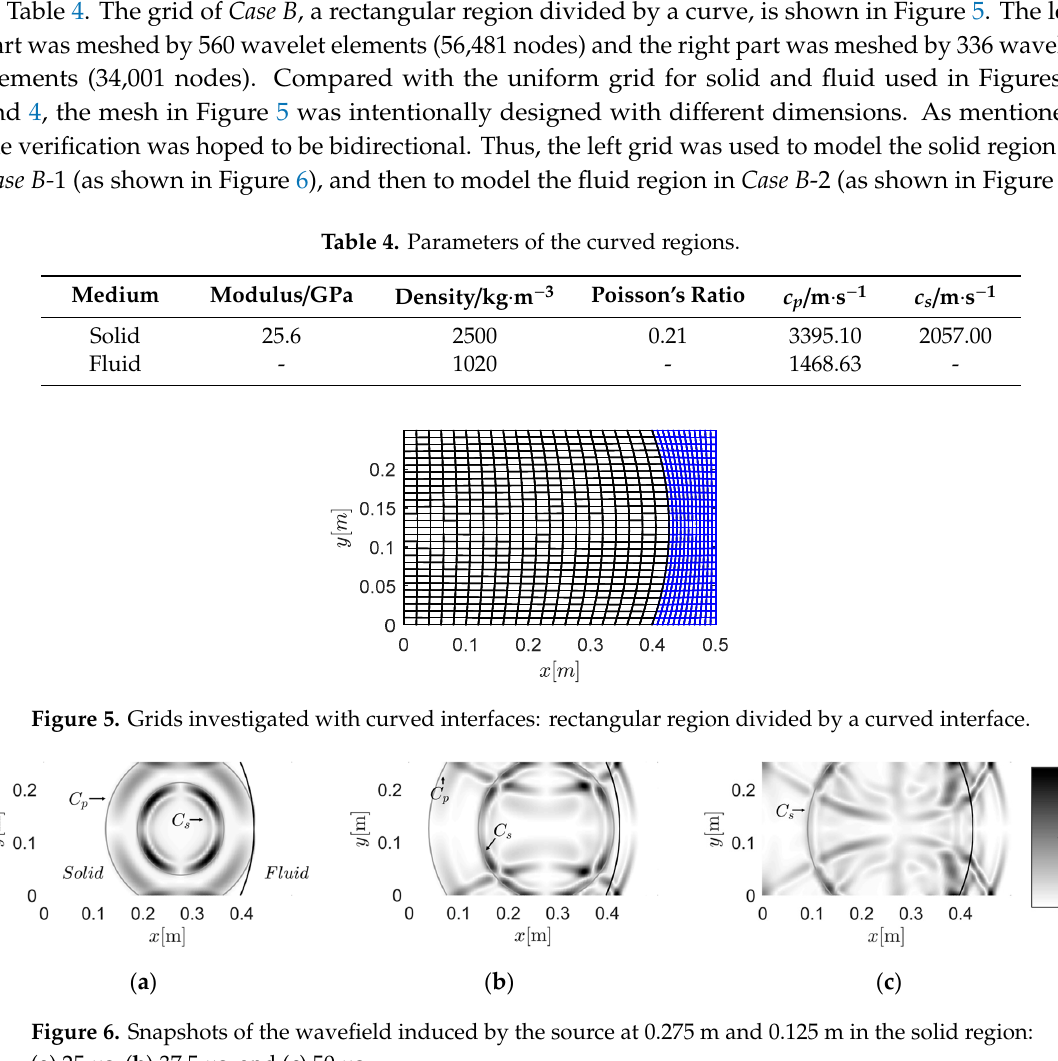
( f ) Figure 7. Snapshots of the wavefield induced by the source at 0.275 m and 0.125 m in the fluid region: ( a ) 50 μ s, ( b ) 75 μ s, ( c ) 100 μ s, ( d ) 125 μ s, ( e ) 150 μ s, ( f ) 175 μ s, and ( g ) 200 μ s. 3.2.1. Case B-1: Wave Travels from Solid to Fluid Figure 6 presents the wave propagation from solid to fluid. The left part was treated as solid and, thus, had 112,962 dofs; while the grid on the right of the interface was used to simulate the fluid, with 34,001 dofs. The source was fixed at 0.275 m and 0.125 m in the solid region. Due to the complexity of the theoretical secondary wavefronts, we only present the main modes in the following